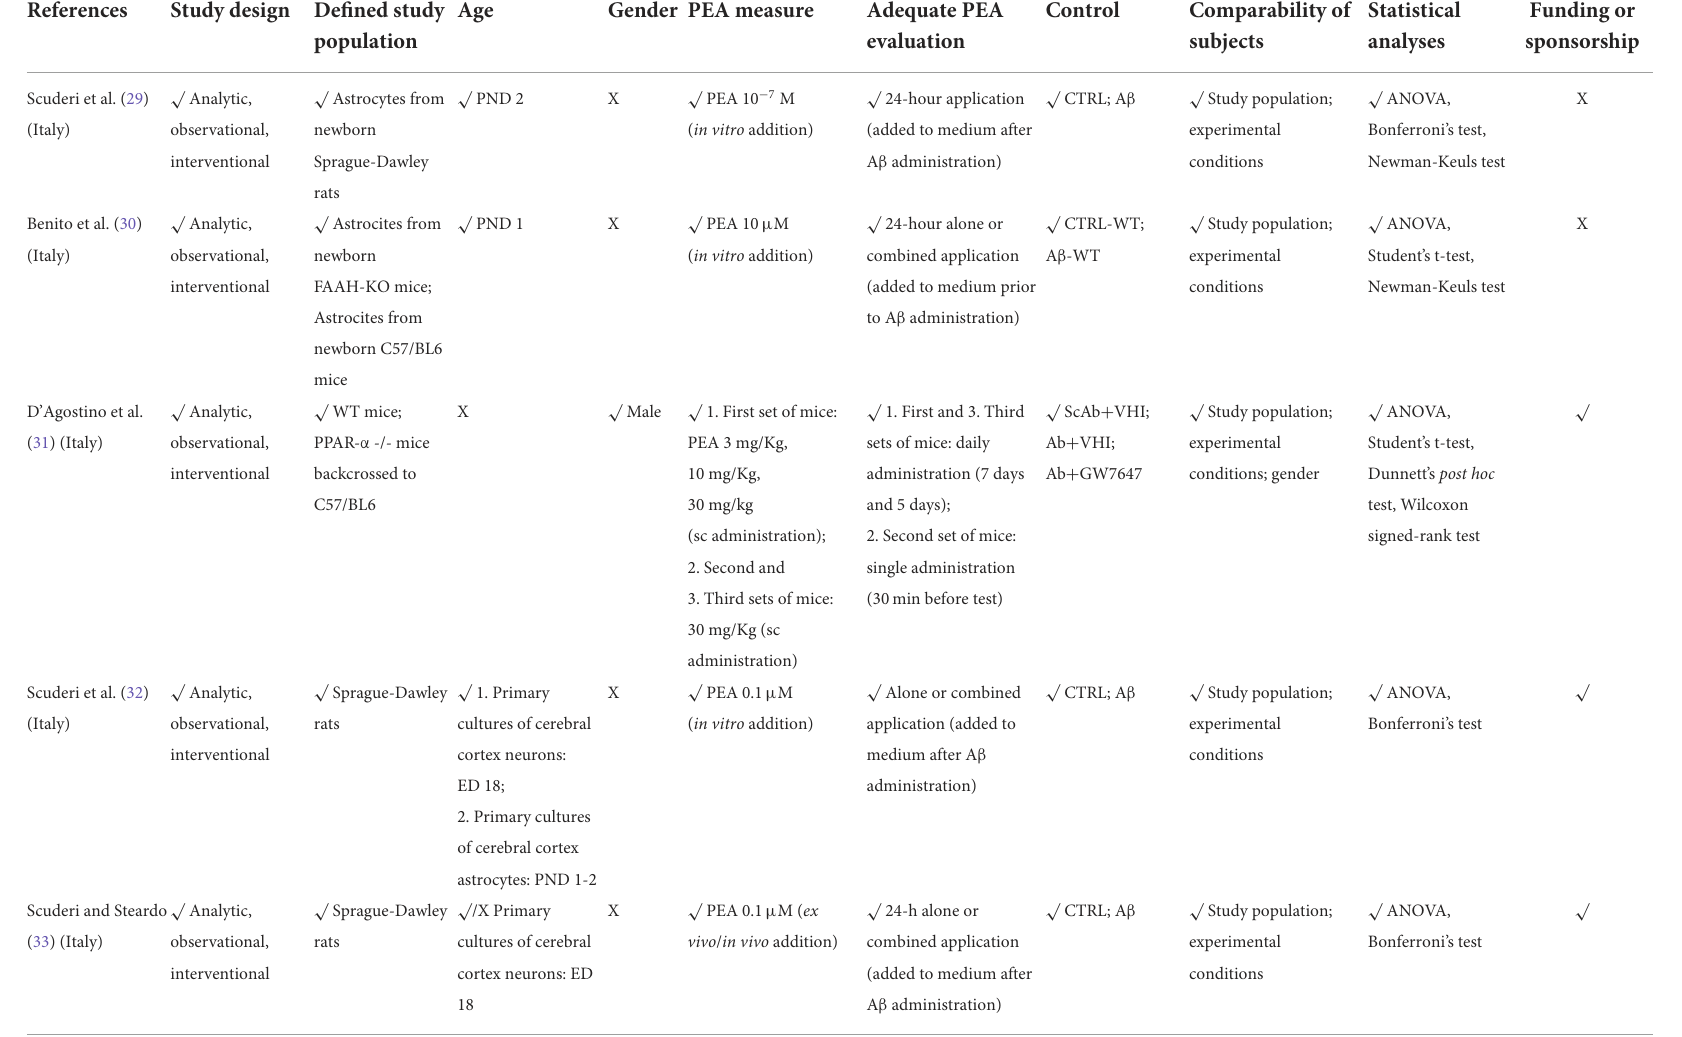
TABLE 2B Methodological quality of preclinical studies investigating palmitoylethanolamide and its correlations to neurocognitive disorders